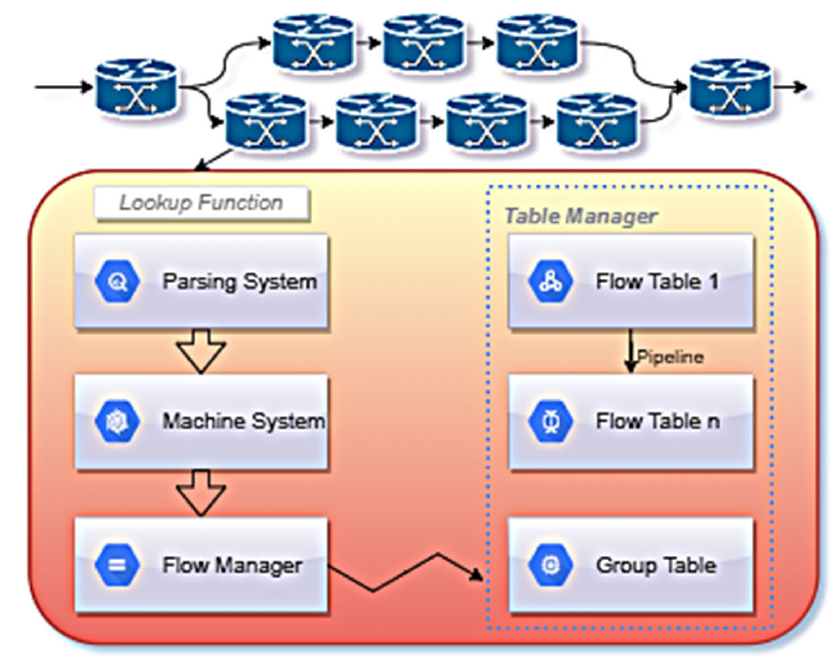
Figure 3. Workflow of data plane.